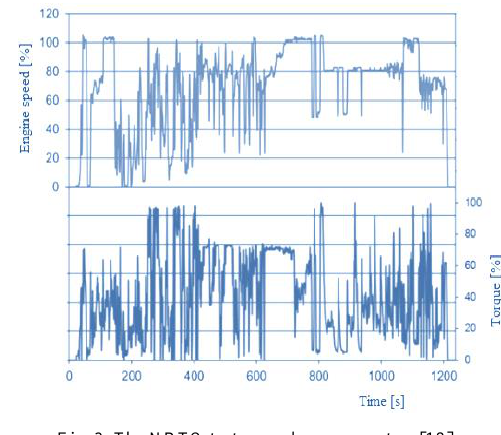
Fig. 3. The NRTC test procedure parameters